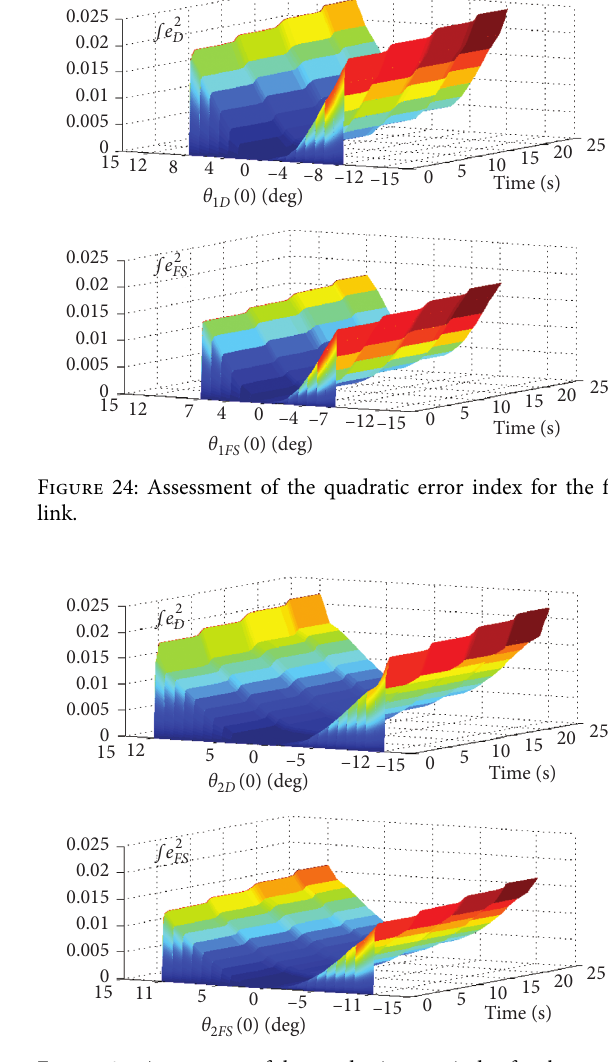
Figure 25: Assessment of the quadratic error index for the second